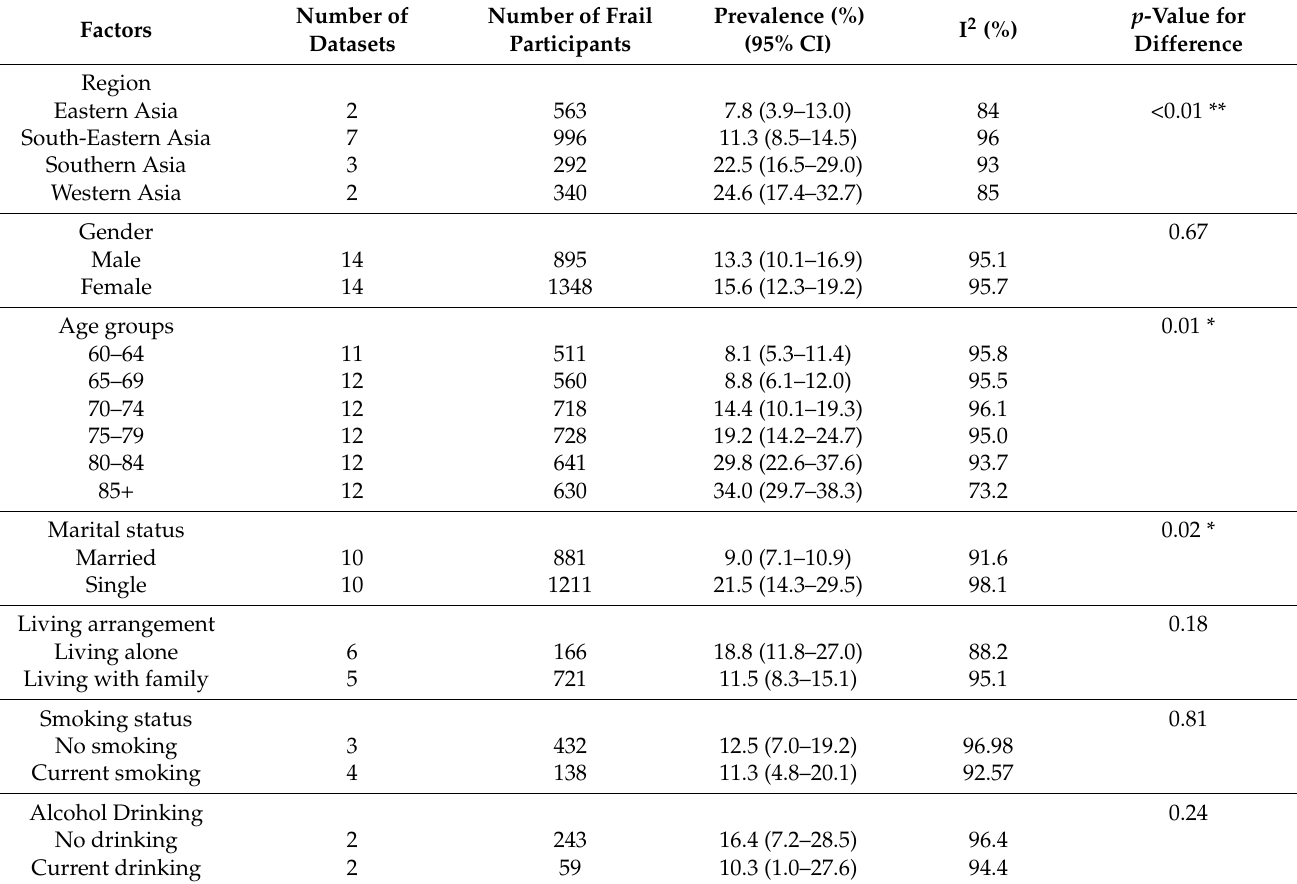
Table 2. Factors associated with pooled prevalence using Fried frailty